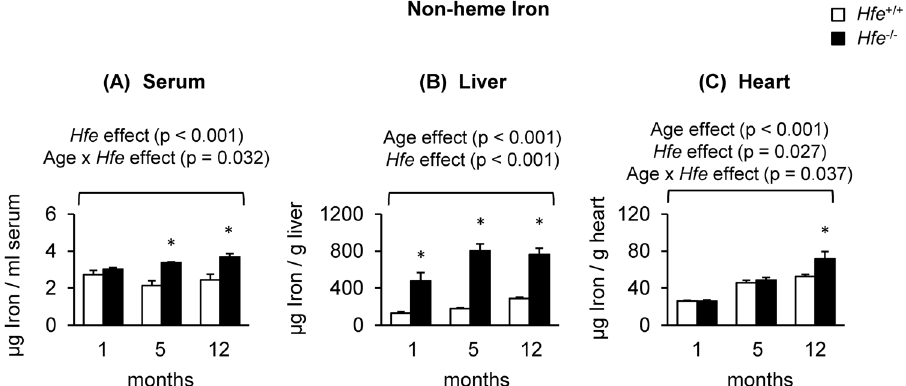
Figure 1. Non-heme iron levels in serum, liver and heart of Hfe + / + and Hfe − / − mice. Non-heme iron content in serum ( A ), liver ( B ) and heart ( C ) was measured colorimetrically using bathophenanthroline (n = 5–9 per group). Data are presented as the means ± SEM. * p < 0.05 between Hfe − / − and Hfe + / + mice assessed by the two- way ANOVA, followed by the Tukey’s post-hoc analysis.